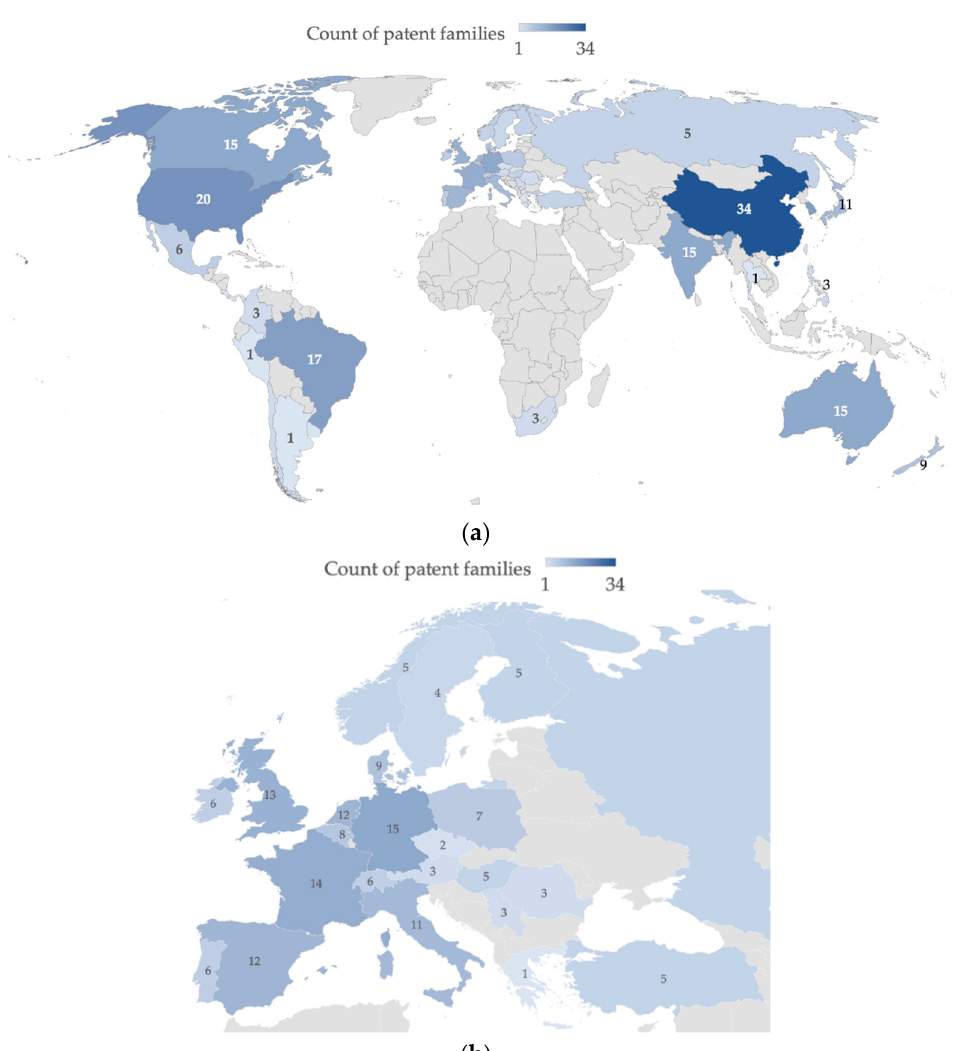
Figure 6. Count of patent families by protection country: ( a ) global scenario; ( b ) focus on European region.